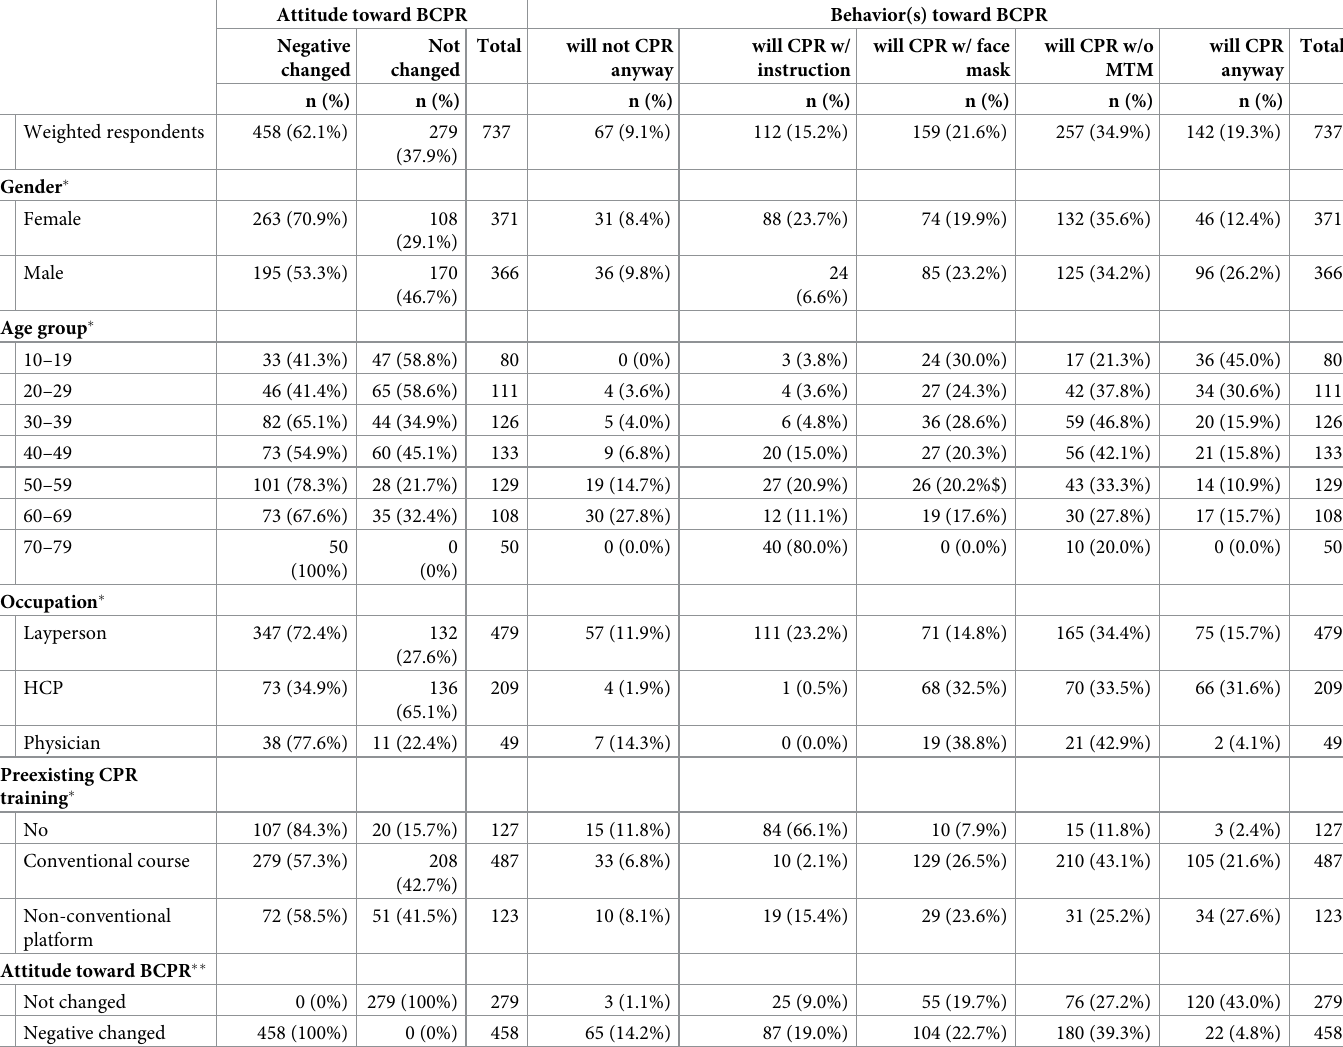
Table 3. Univariate association between survey predictors and willingness toward BCPR: Weighted